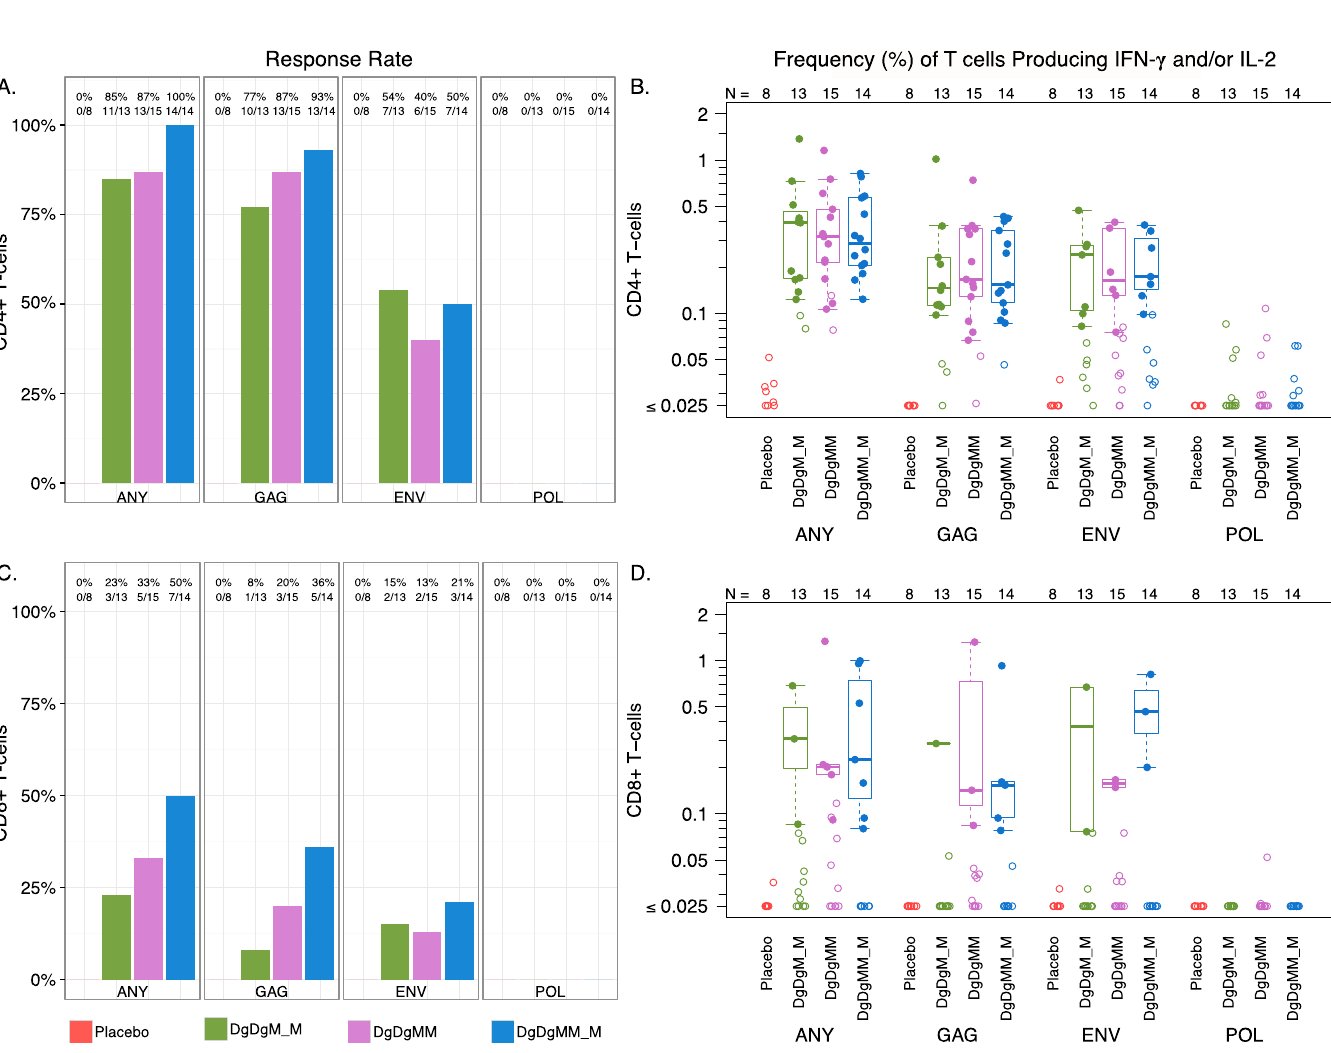
Fig 7. Cellular immune responses measuredby intracellular cytokine staining (ICS). (A) CD4+ responserates. (B) CD4+ response magnitude. (C) CD8+ response rate. (D) CD8+ response magnitudes. Peak ICS response rates and responsemagnitudeto Gag, Env and Pol in the CD4+ (Panels A & B) and CD8+ (Panels C & D) T-cell subsets at two weeks after the 2nd and 3rd MVA or placeboin the Placebo, DgDgM_Mand DgDgMM_Mgroups. DgDgM_M refers to immune responses after the last MVA in the DgDgM_Mgroup; DgDgMM and DgDgMM_M refer to immune responses after the 2nd and 3rd MVA in DgDgMM_Mgroup, respectively.Shownare responserates (A, C) and responsemagnitudes (B, D) for the sum of individualantigenresponses, reportedas % of CD4+ or CD8+ T cells producing IFN-gamma and/or IL-2. Positive responsesare shown as filled circles and negativeresponsesare shown as open circles (B, D). Box-plots represent the distribution for the positive respondersonly. Responserates were comparedusing Fisher’s exact test (A, C); response magnitudes amongrespondersacross treatment arms were comparedusing Wilcoxon Rank Sum test (B,